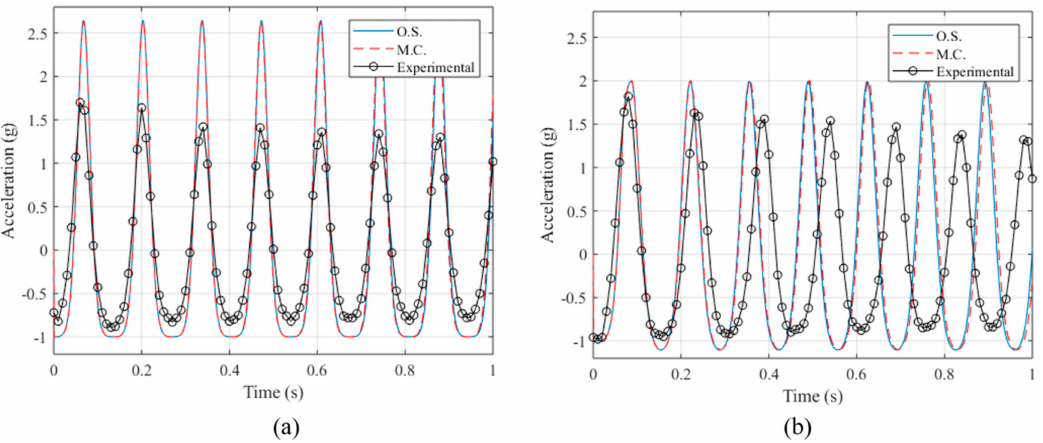
Figure 9. Dynamic experimental results: ( a ) elastic and ( b )